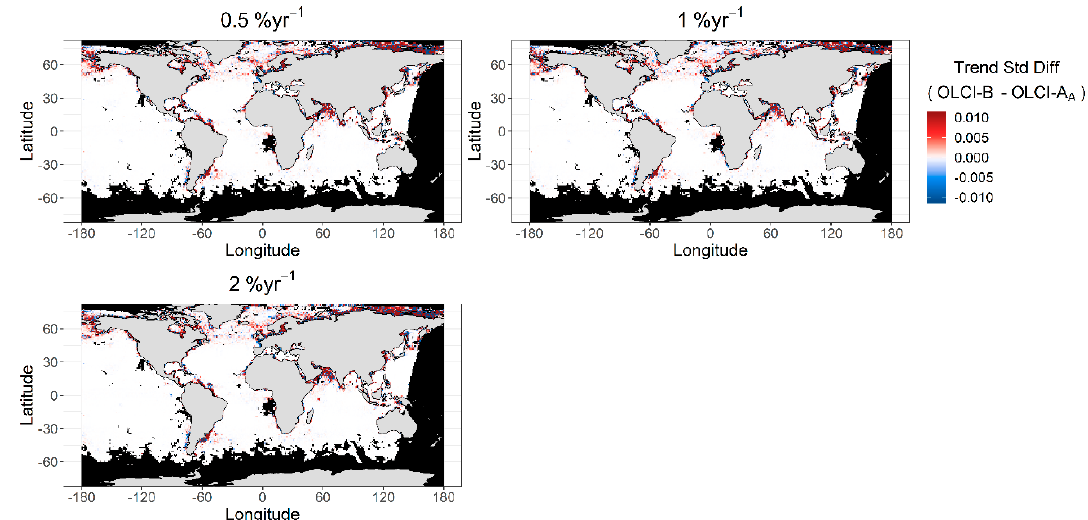
Figure A5. Global 1 ◦ maps of the di ff erences between the standard deviation of all chl- a trend estimates from all bootstraps for OLCI-A-Aligned and OLCI-B in each grid cell. The value expressed in percent per year above each subplot indicates the trend imposed on the synthetic time series. Red indicates that OLCI-B has higher standard deviation of chl- a trend estimates than OLCI-A-Aligned. Black grid cells indicate where missing data prevents analysis.